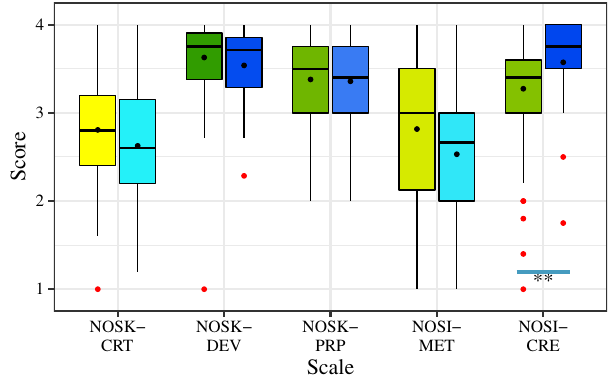
FIG. 3. Adequateness of students ’ (left) and professors ’ (right) beliefs. Higher scores indicate more appropriate beliefs in the respective areas. Horizontal bars indicate scale medians, black dots indicate arithmetic means, red dots represent outliers. Significant differences between groups in U-test are